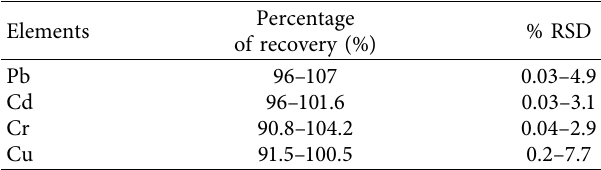
Table 5: Te heavy metals recovery and precision test results of vegetable samples with matrix spike (range, n �